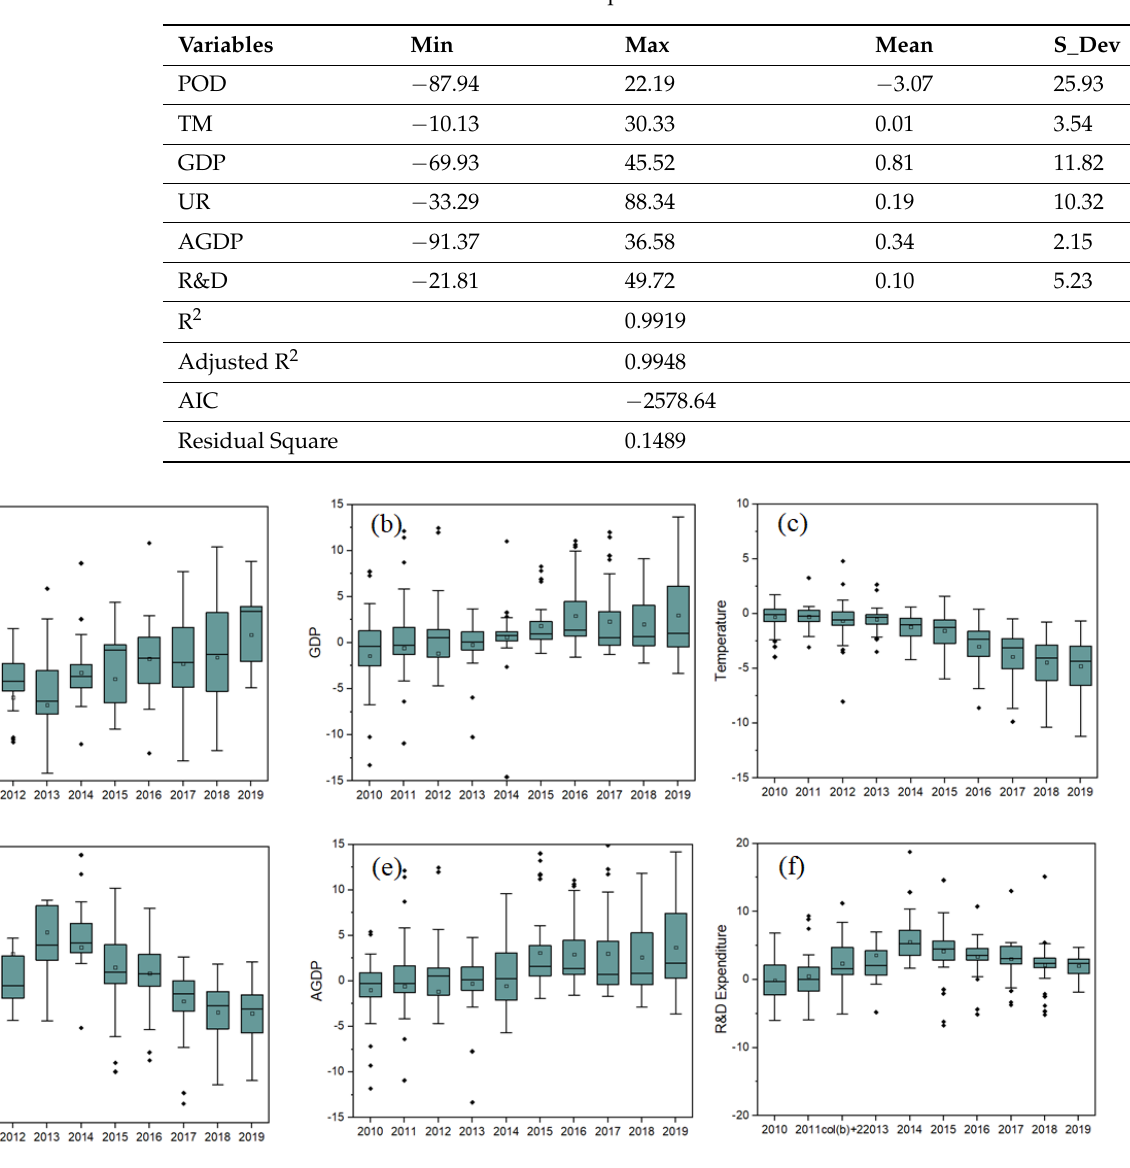
Figure 5. The changing trend of GTWR regression coefficients with time for ( a ) POD, ( b ) GDP, ( c ) TM, ( d ) UR, ( e ) AGDP, and ( f ) R&D expenditure, respectively.